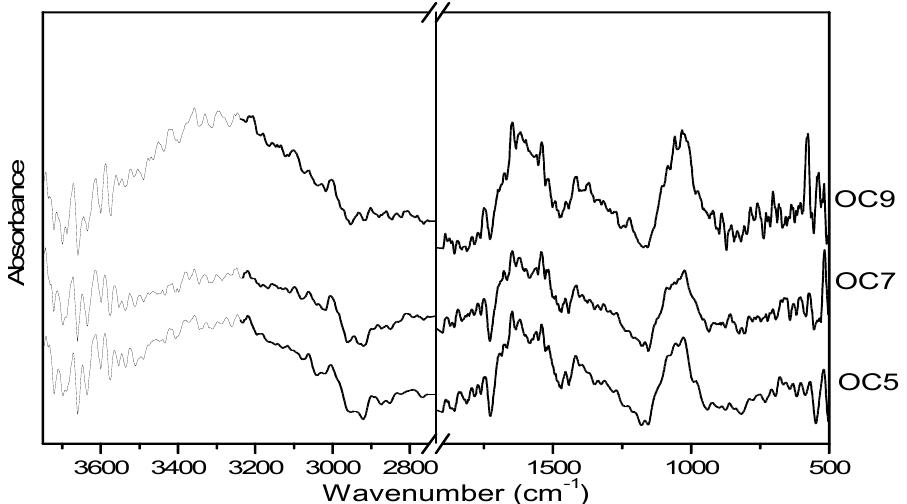
Figure 2. Fourier-transform infra-red spectroscopy (FTIR) spectra of the partially composted waste extracts obtained at pH 5 (OC5), at pH 7 (OC7), and at pH 9 (OC9).